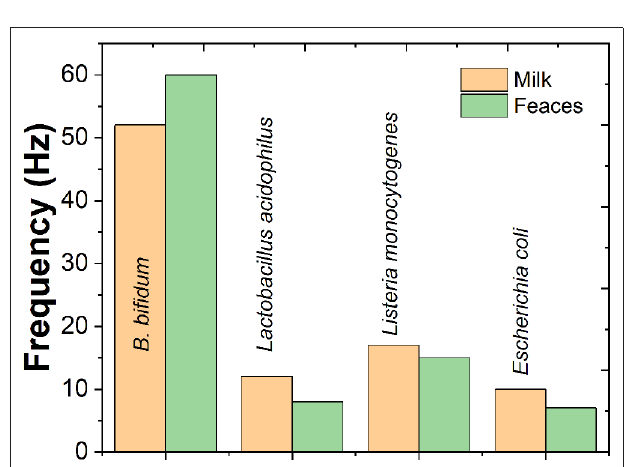
FIGURE 7 | Specific detection of 10 4 CFU/mL of B. bifidum, Lactobacillus acidophilus , Listeria monocytogenes and Escherichia coli inoculated on milk and feces